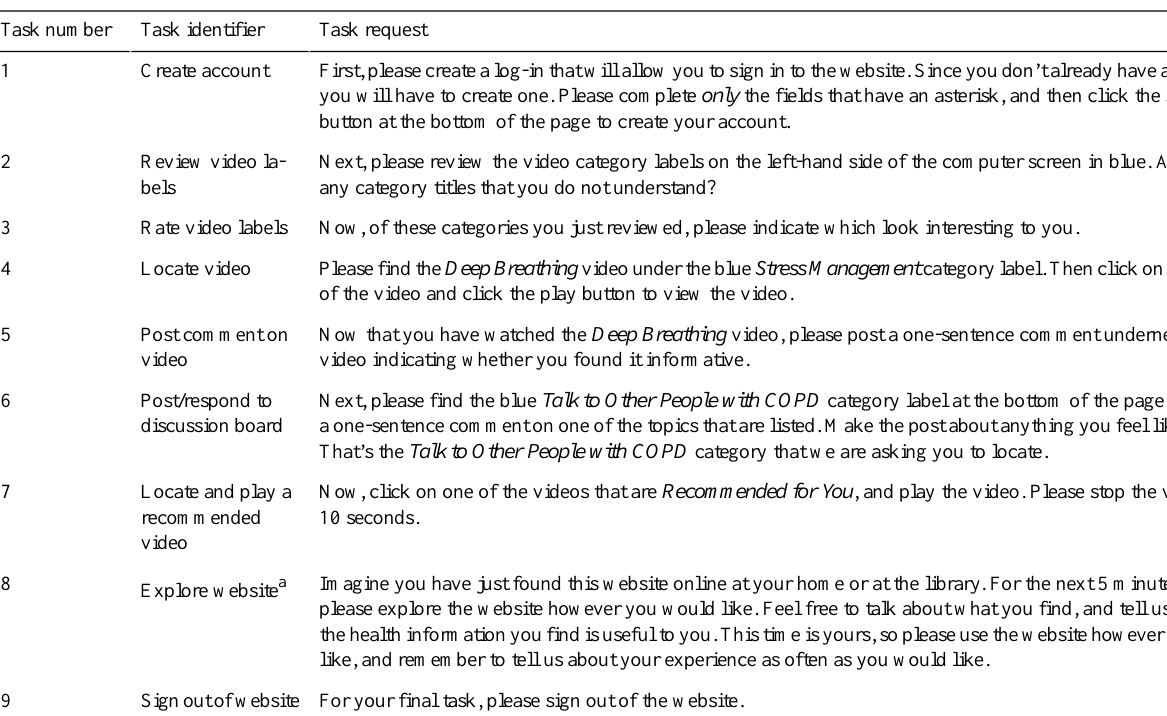
Table 1. Nine think-aloud usability social media task directives.